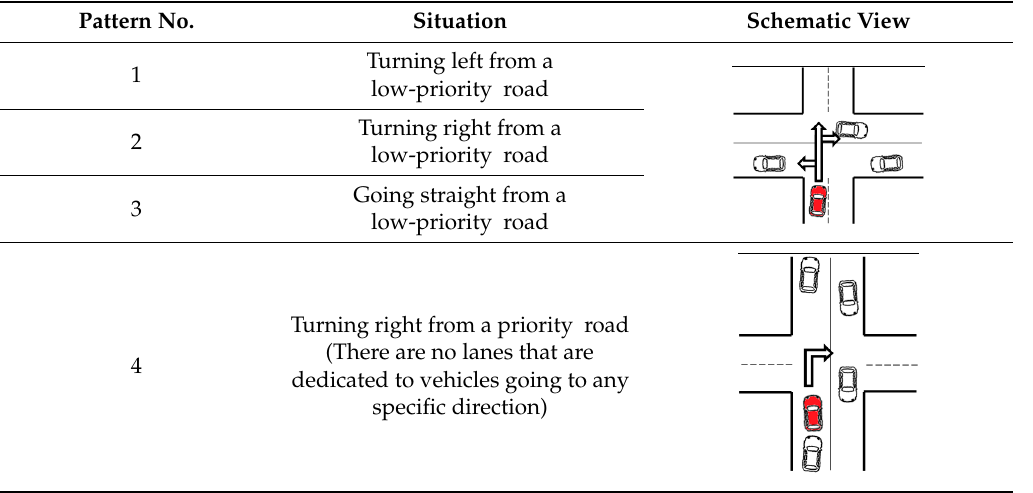
Table 3. Situations in which yielding is required.